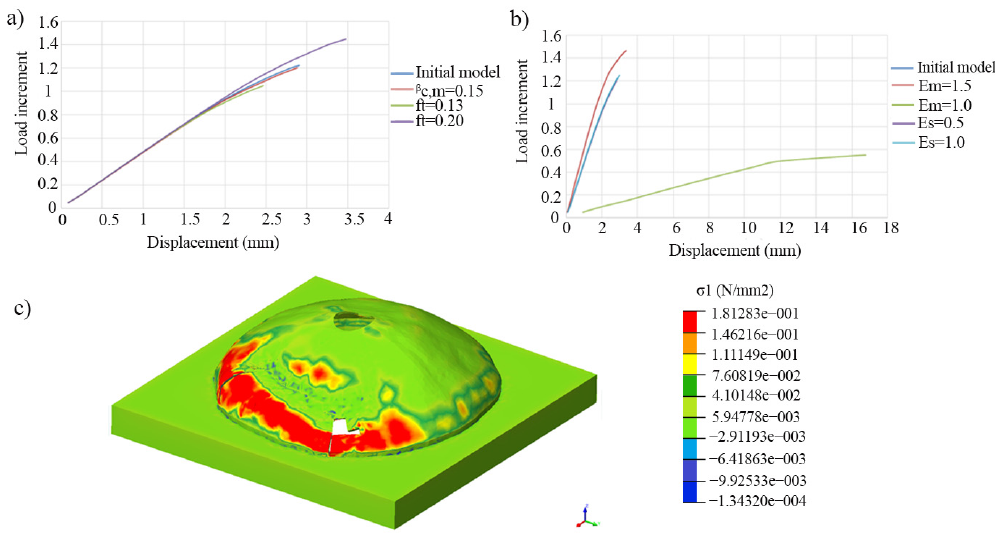
Figure 13. ( a ) Parametric analysis of different tensile strengths and shear retention factors; ( b ) Parametric analysis of different masonry and infill’s Young modulus; ( c ) Maximum principal stress ( σ 1 ), expressed in N/mm 2 , at collapse of the initial considered model.